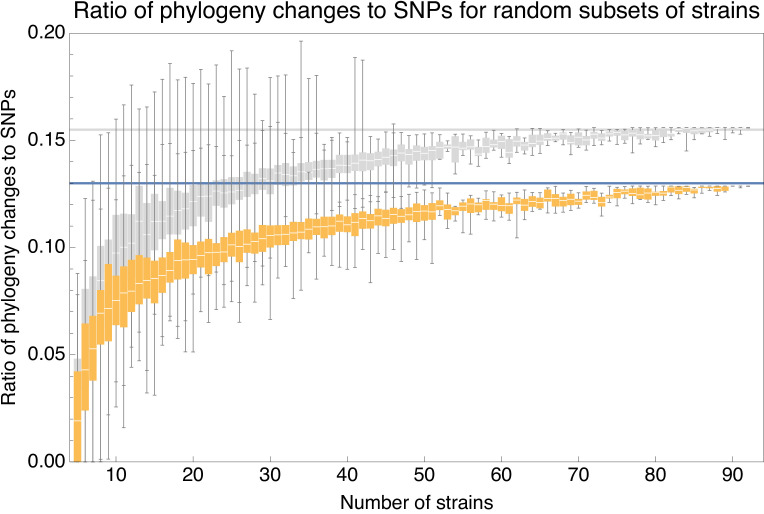
Ratios C/M for homoplasy-corrected and full alignments of random subsets of strains.Ratio C/M of the minimal number of phylogeny changes C to substitutions M for random subsets of strains using the alignment for which 5% of potentially homoplasic positions have been removed (orange) as well as for the full alignment (gray). For strain numbers ranging from n=4 to n=92, we collected random subsets of n strains and calculated the ratios C/M of phylogeny changes to SNPs in the alignment. The figure shows box-whisker plots that indicate, for each strain number n, the 5th percentile, first quartile, median, third quartile, and 95th percentile of the distribution of C/M across subsets. The blue line shows C/M=0.129 and the gray line C/M=0.155.